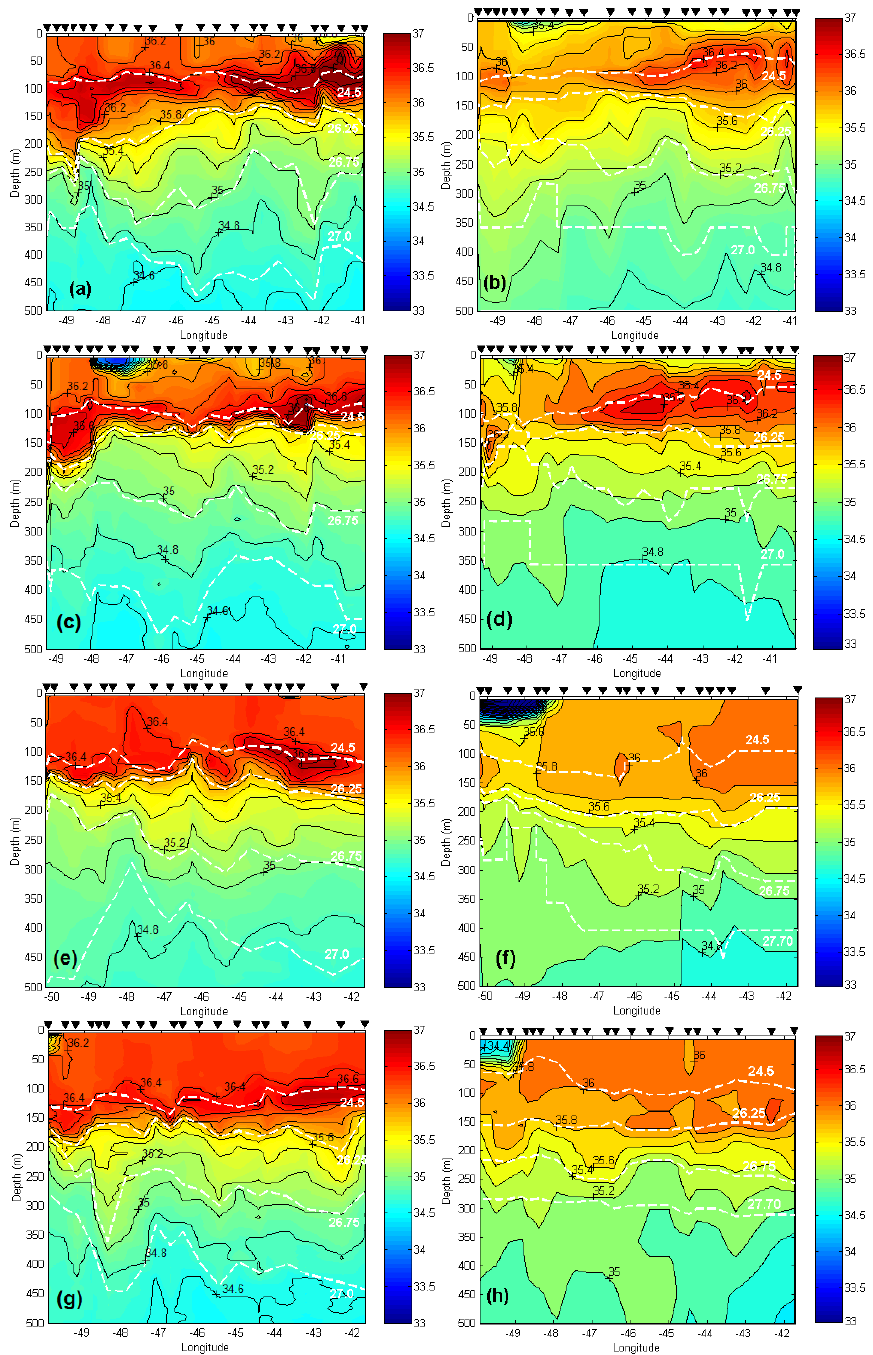
Fig. 3. Vertical distribution of salinity from the surface down to 500m depth along transects almost parallel to the coast is indicated by a solid straight gray line (see Fig. 1) during REVIZEE cruises from field data and CLIPPER model results: (a) hydrographic data for March–May 1995, (b) model results for March–May 1995, (c) hydrographic data for May–June 1999, (d) model results for May–June 1999, (e) hydrographic data for July–August 2001, (f) model results for July–August 2001, (g) hydrographic data for October–November 1997 and (h) model results for October–November 1997. The superimposed dashed lines (white) indicate the depth of the σ θ =24.5, 26.25, 26.75 and 27.70kgm − 3 . In the left panels, inverted (black) triangles represent the location of hydrological stations during the cruises. In the right panels, the same triangles represent the selected numerical model grid nodes coincident with the cruise hydrological